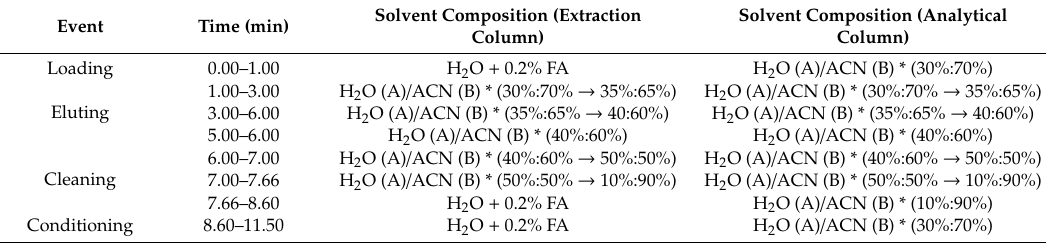
Table 4. Analytical steps involved in the automated multidimensional extraction / determination of the